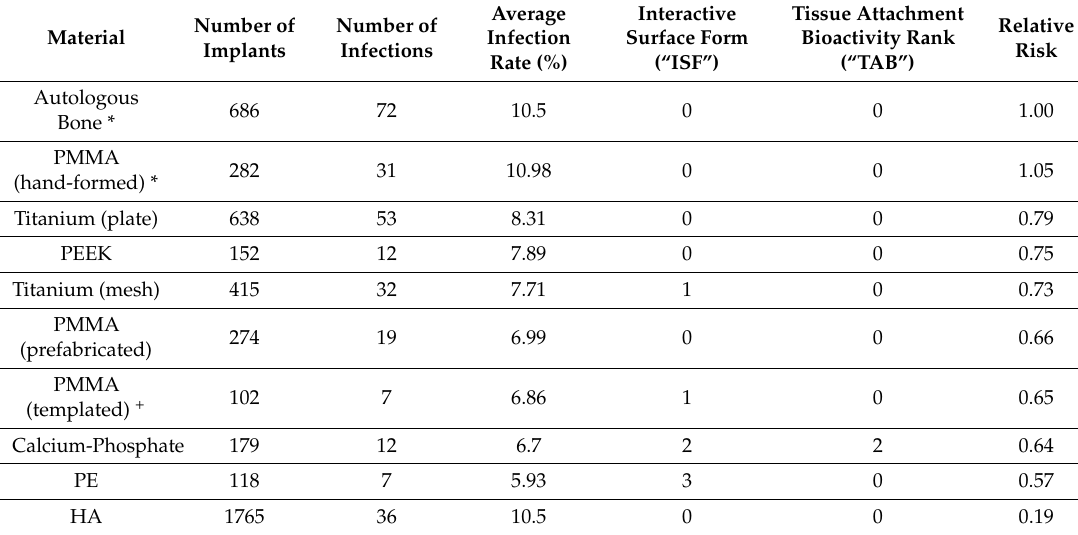
* Indicates implant formation via direct handling of the implant material in surgery; + Indicates implant formation via custom molding template in surgery.